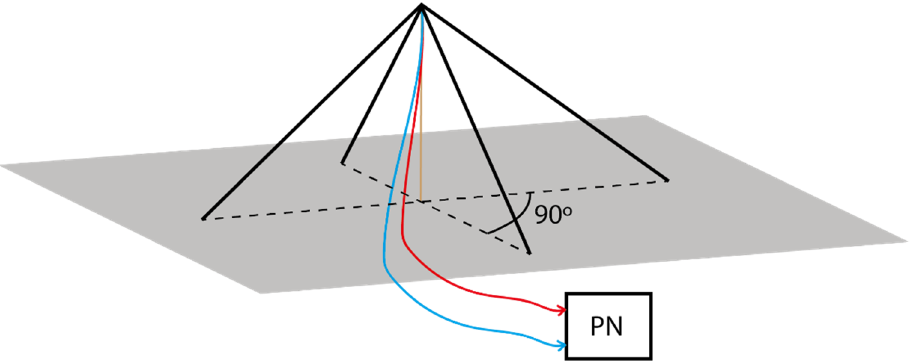
Figure 3. Diagram of the orthogonal inverted vee antennas in the receiver.